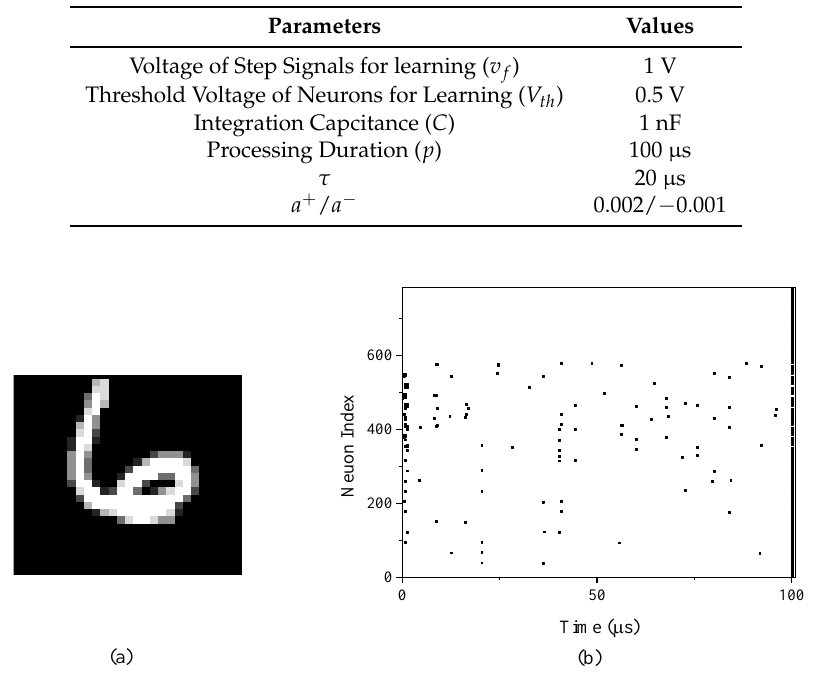
Figure 3. ( a ) An image of “6”, ( b ) spike times of input neurons after